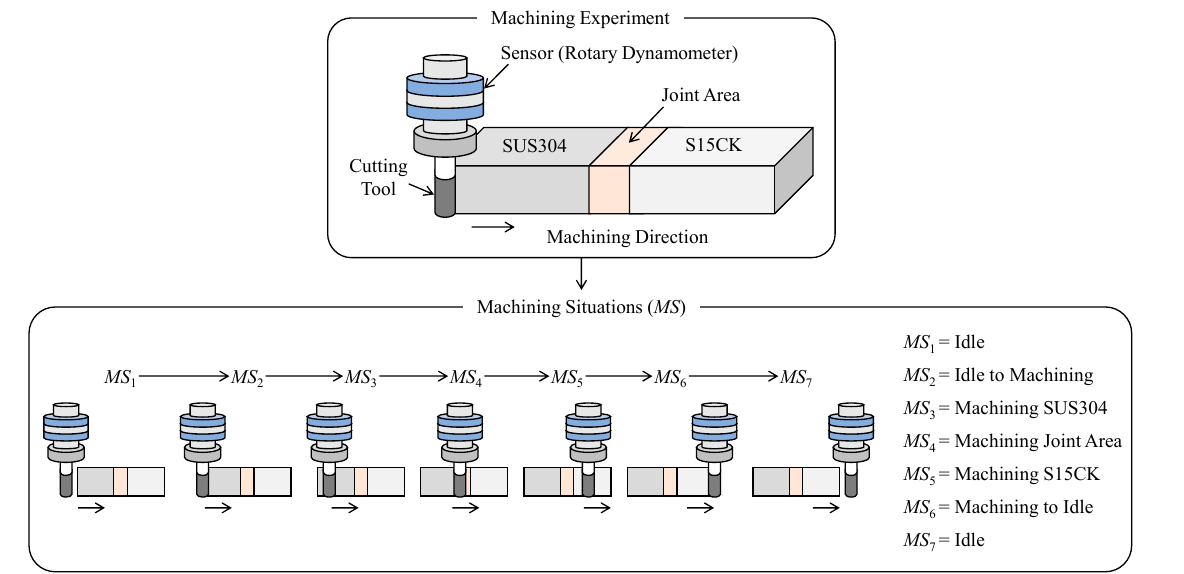
Figure 13. Machining situations underlying the machining experiment. Table 4. Machining conditions for machining a multi-material